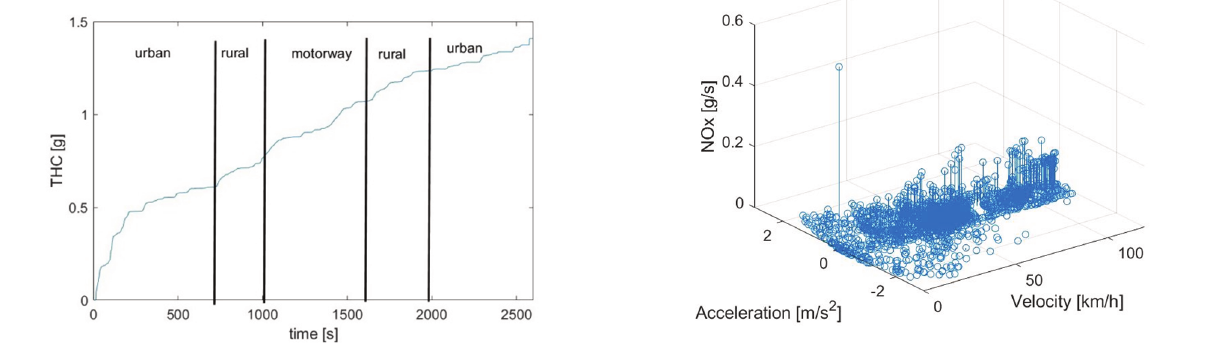
Fig, 8. Emission of THC for Euro 3 LPG fuelled vehicle